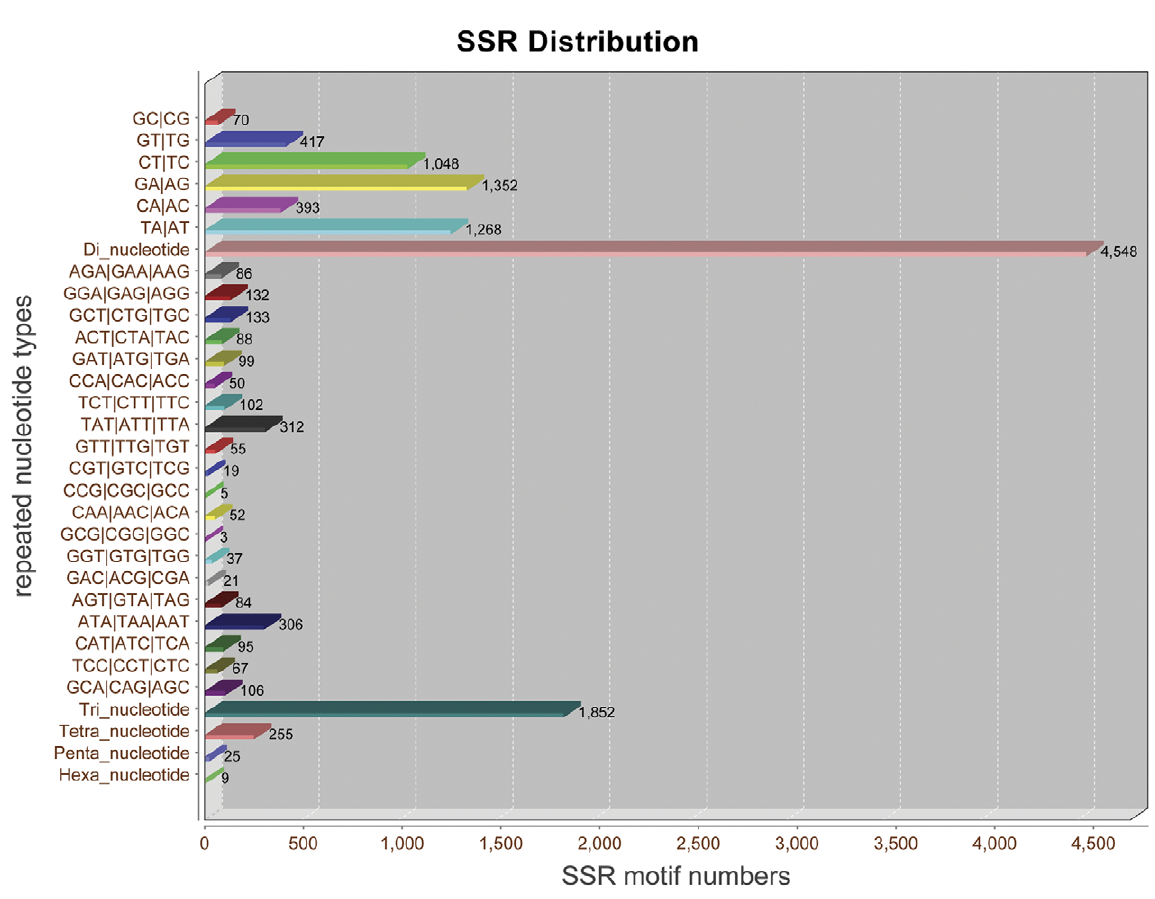
Figure 4. Distribution of simple sequence repeat (SSR) nucleotide classes among different nucleotide types found in the transcriptome of M.nipponense. Both contig and singleton sequences are used to predict the SSR loci.